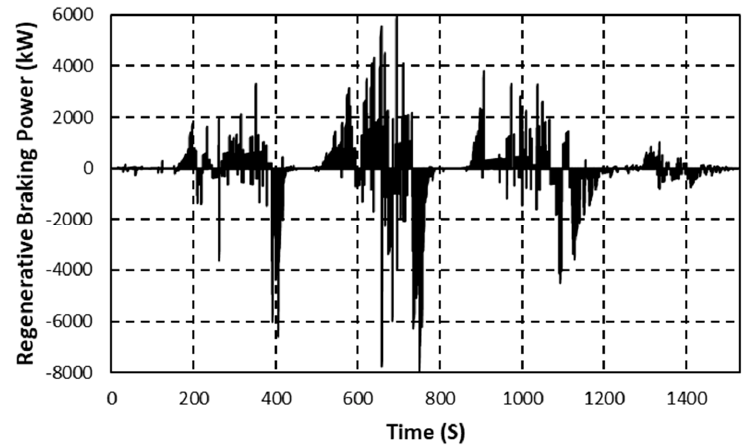
Figure 6. Regenerative braking power.